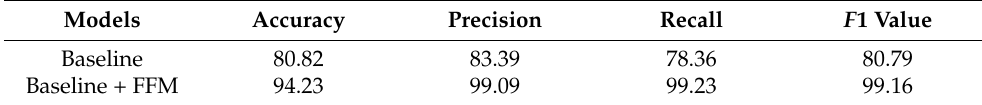
Table 4. Analysis of ablation experiments for image size 256 × 256 (%).